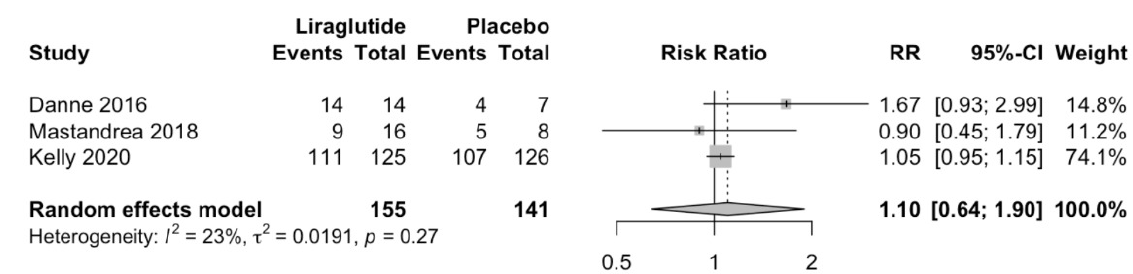
Figure 5. Effect of Liraglutide in hypoglycemic episodes [5,30,31].